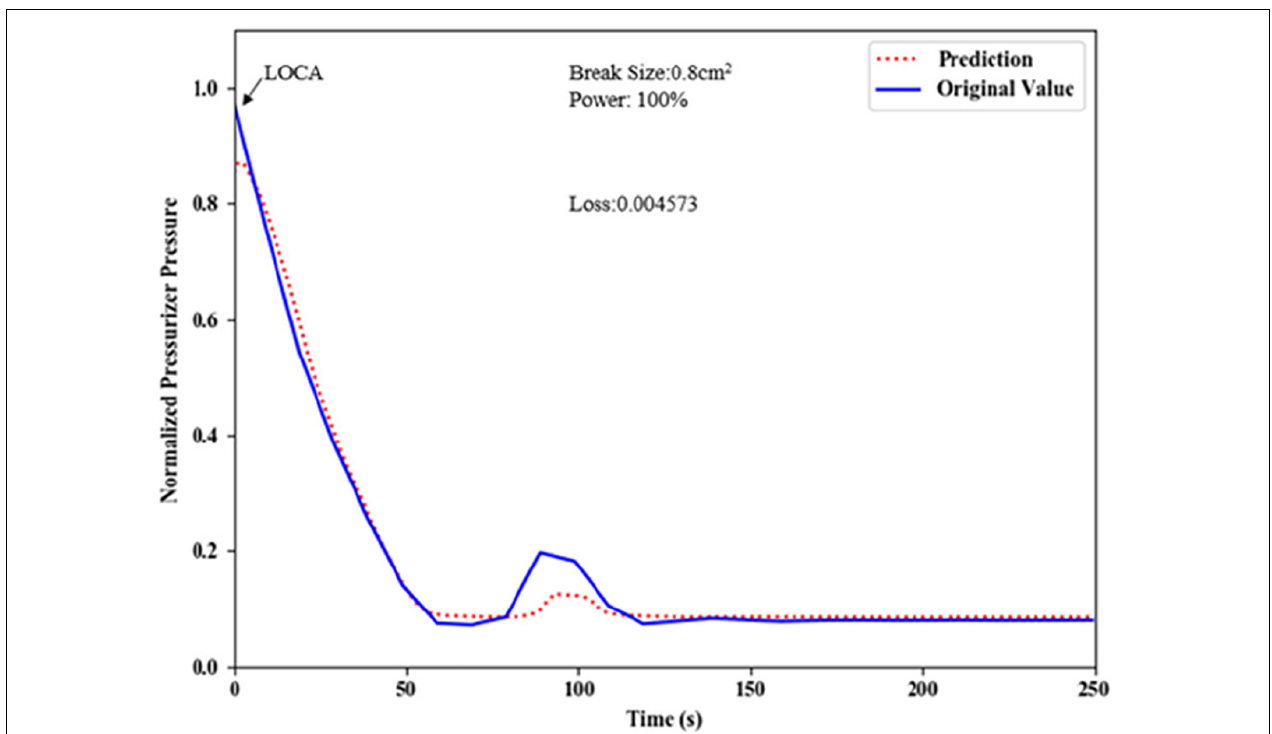
FIGURE 7 | Pressurizer pressure prediction for 0.8 cm 2